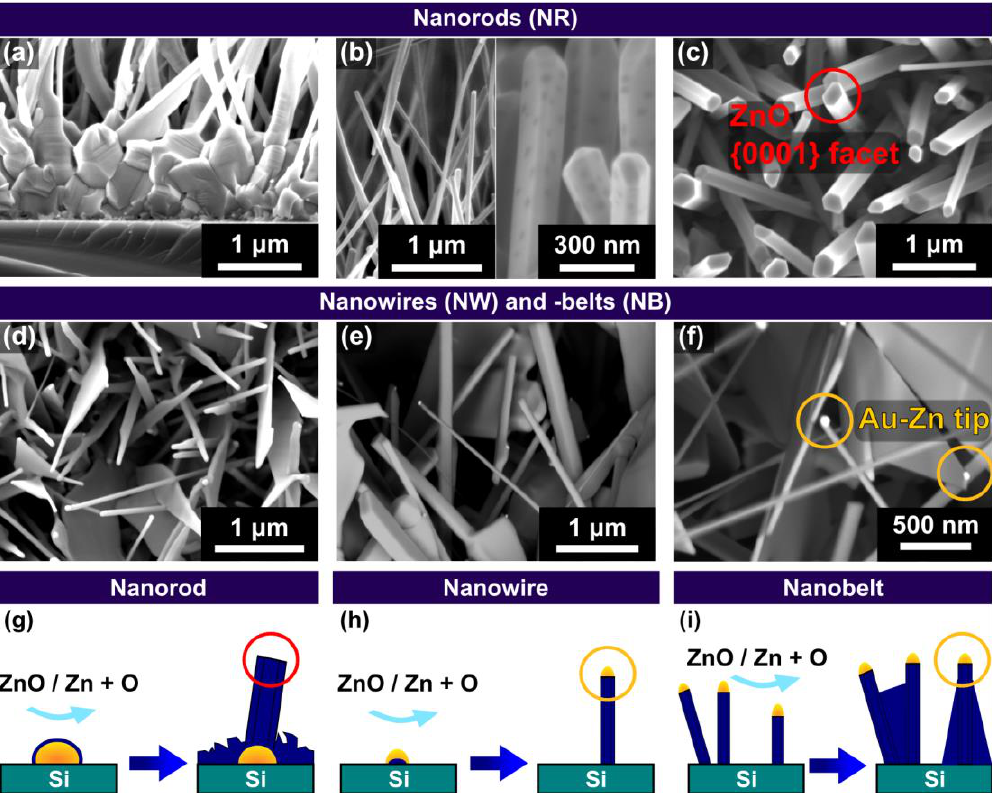
Figure 3. SEM micrographs ( a , b : cross-sections) of ZnO-nanorods (NRs, a – c ), -nanowires (NWs, d – f ) and -nanobelts (NBs, d – f ). High magnification images of NRs ( c ) show the flat ZnO {0001}-facets of VS-grown nanostructures, whereas the different VLS growth mechanism for NWs and NBs ( f ) is seen by the bright Au-Zn alloy particle at their tip. ( g – i ) Schematic representation of the growth mechanisms of NRs ( g ), NWs ( h ), and NBs ( i ). (dark blue: ZnO, cyan: Zn vapor, orange: Au, turquoise: Si-substrate).